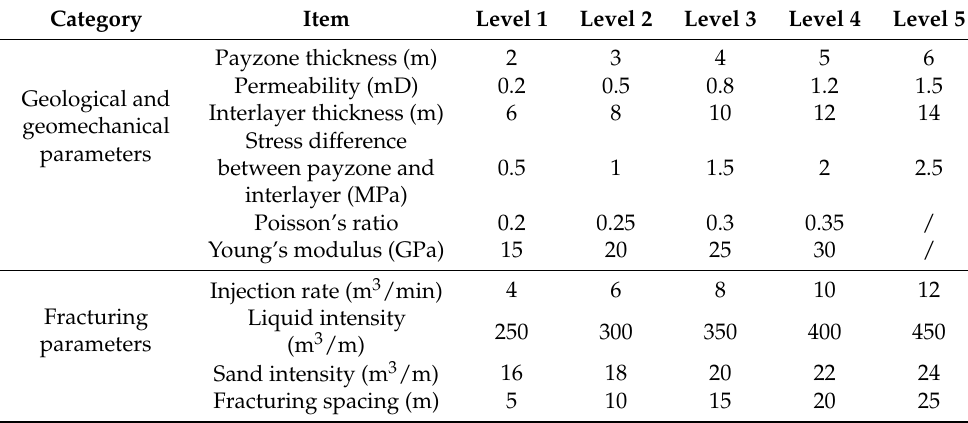
Table 2. Spatial distribution of fractures under heterogeneous conditions.